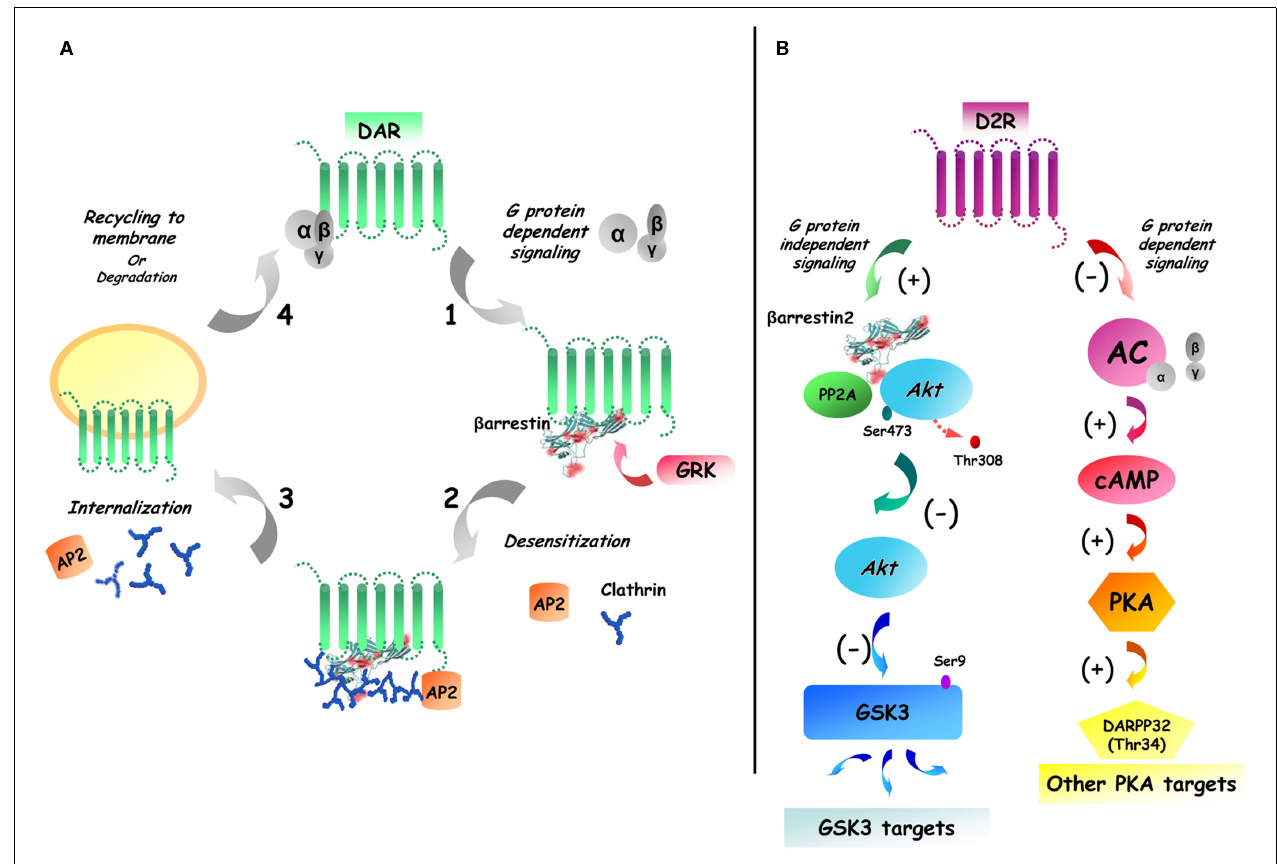
and G protein-independent beta-arrestin-mediated signaling of D2R. Receptor activation leads to both classical G protein mediated signaling and to the formation of complexes of signaling molecules that are associated together by beta-arrestins. In the specific case of striatal D2R beta-arrestin 2 has been shown to enhance the interaction between Akt and protein phosphatase 2A (PP2A) therefore resulting in Akt inactivation and increased activation of